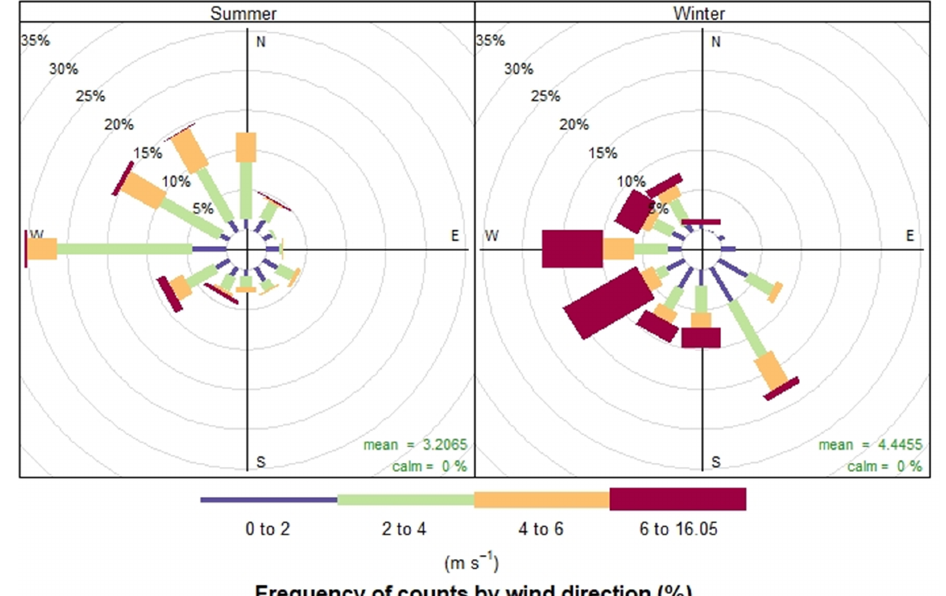
Figure A2. Wind roses for summer and